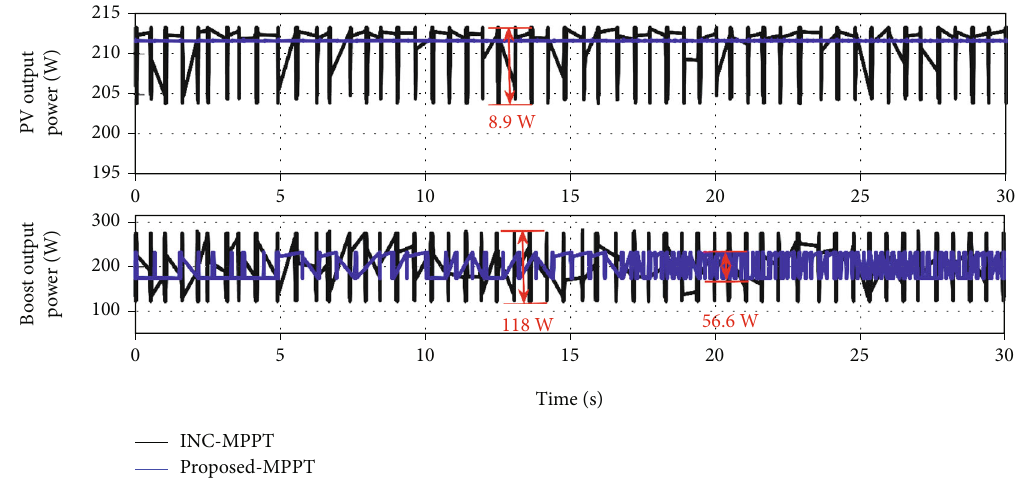
Figure 26: RT-LAB real-time results of the PV array and TLBC power waveforms of both MPPT schemes under